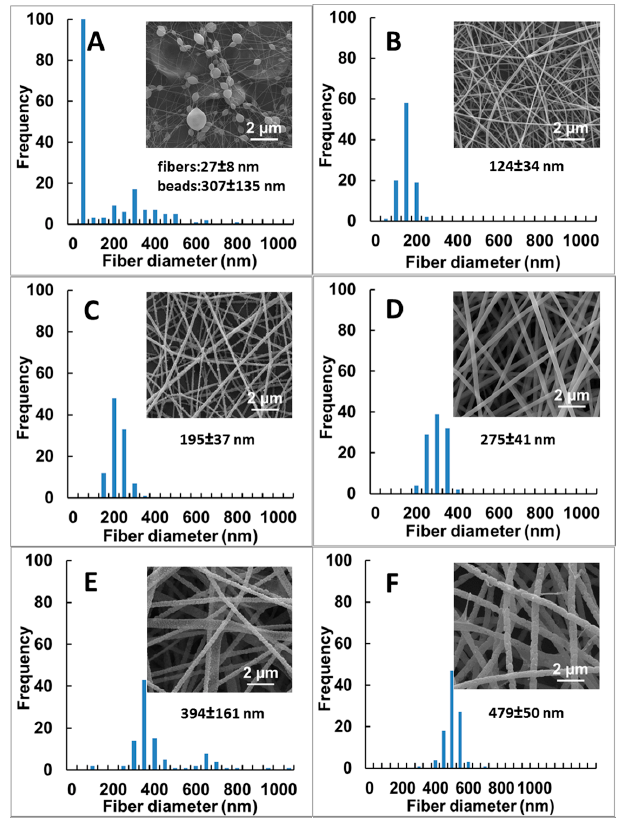
Figure 1. Cont. Figure 1.